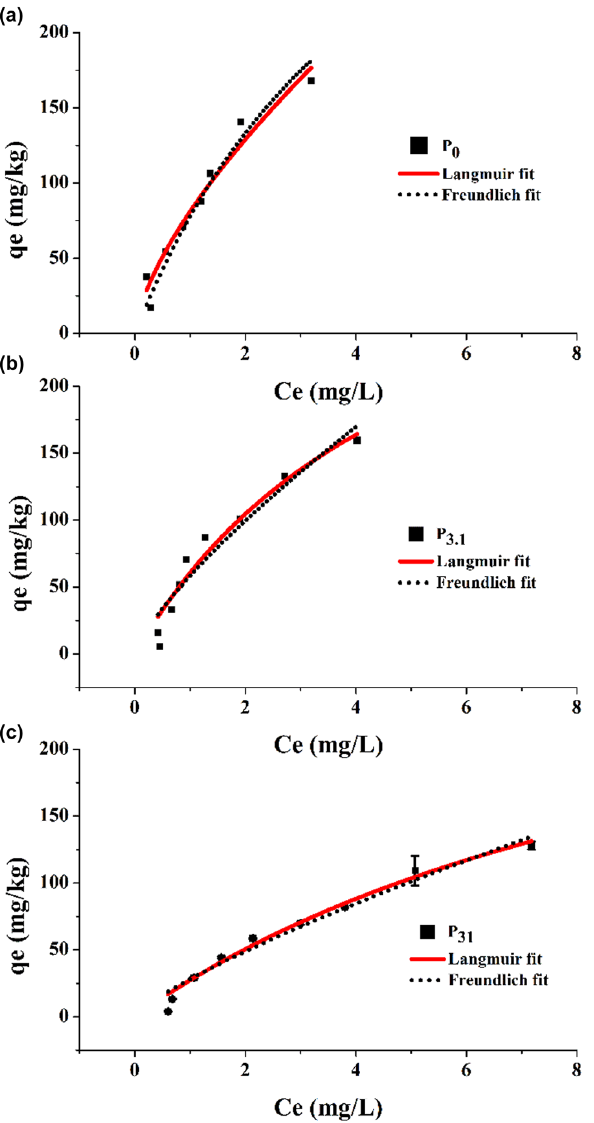
Figure 3: ( a ) Mo adsorption amount and ( b ) adsorption rates in response to the di ff erent P addition